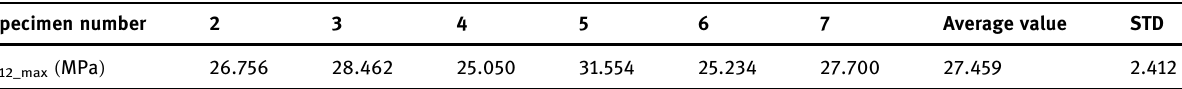
Table 2: Experimental shear strength values for the tested samples